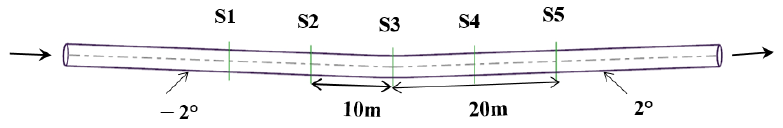
Figure 1. Schematic of the V-inclined